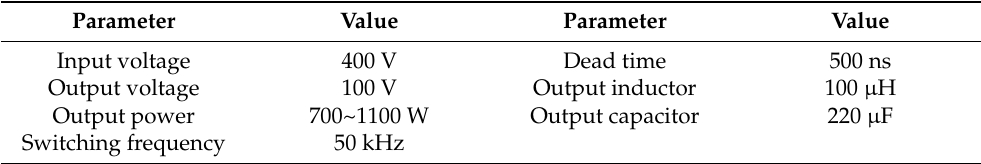
Figure 11. Spikes of spurious pulses at different working conditions, ( a ) I L and ( b ) V DC .